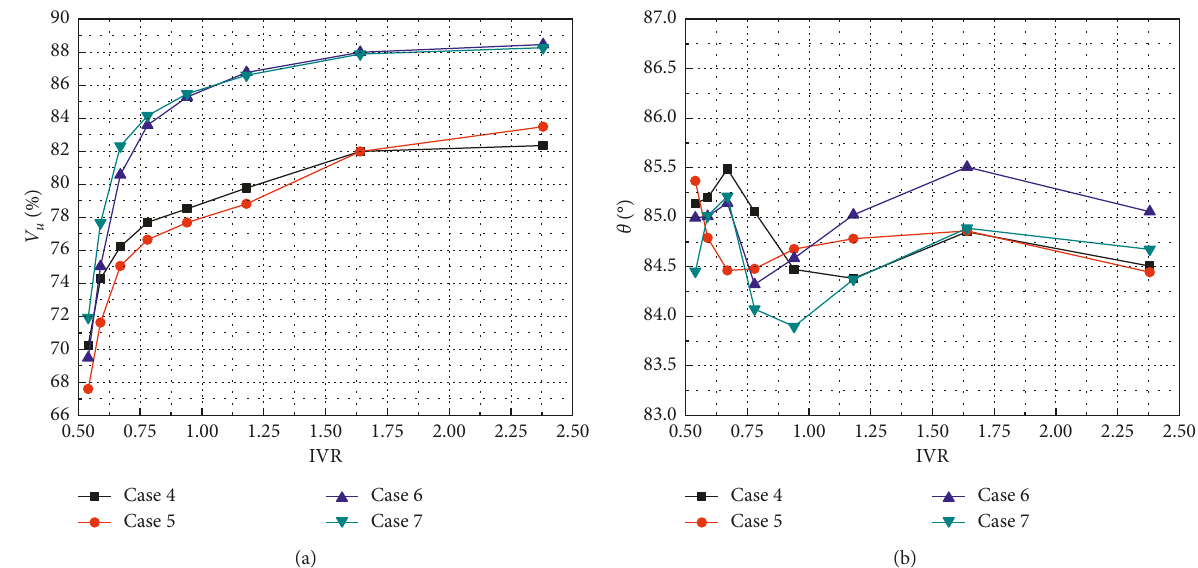
Figure 23: Hydraulic characteristics of inlet passage outlet with different dip angles. (a) Axial velocity distribution coefficient V Weighted-velocity average swirl angle θ